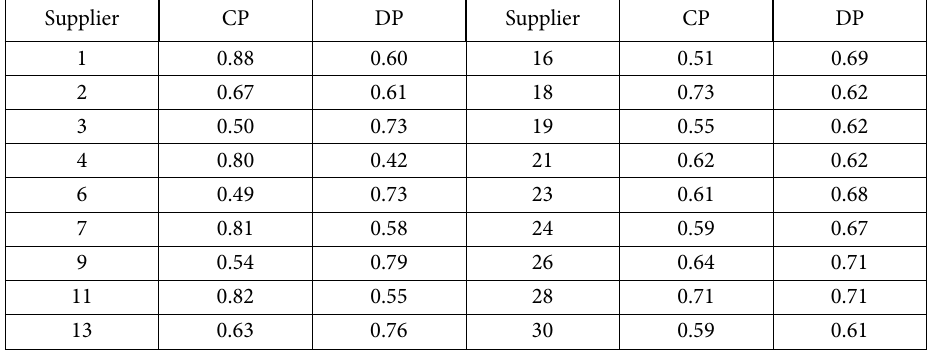
Table 26. Comparative and diversity performance for intake air pressure sensor